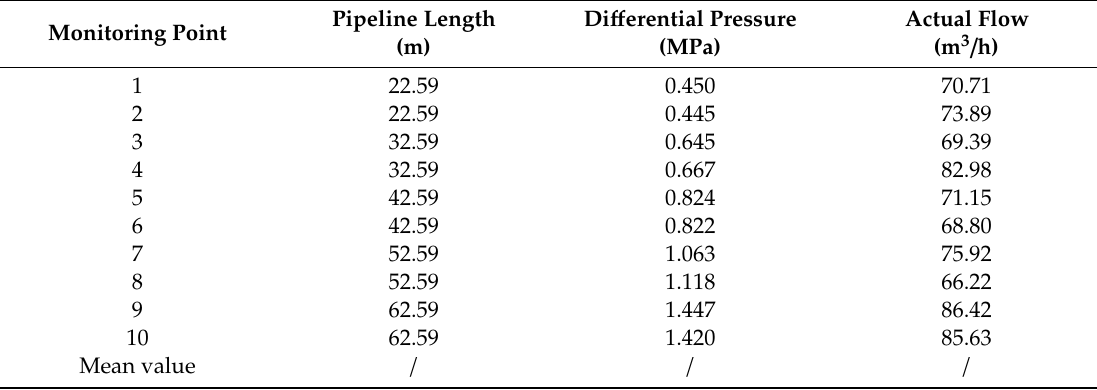
Table 3. Monitoring results of tailings-hemihydrate phosphogypsum filling slurry pressure and flow.